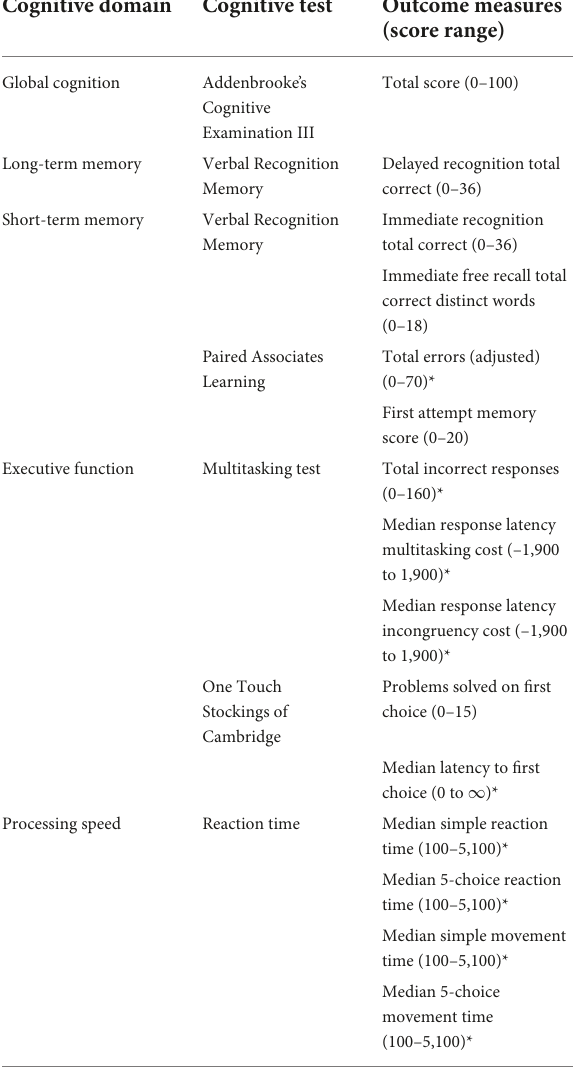
TABLE 1 Cambridge Automated Neuropsychological Test Automated Battery outcome measures and composite